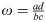
Contingency tables with fixed odds ratio.While the odds ratio, ω=adbc, is fixed in these tables, the proportions are not. The Yule Q statistic is also invariant because it is related to ω by the linear fractional transformation Q=ω-1ω+1.